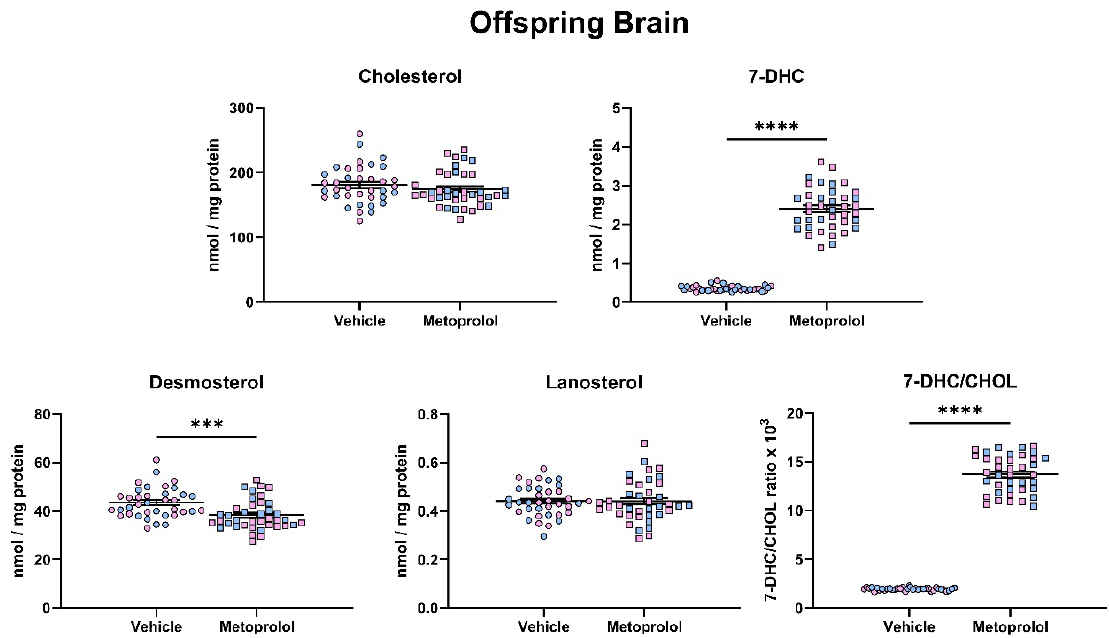
Figure 5. Maternal exposure to metoprolol results in strong elevation of 7-DHC and decreased desmosterol levels in the offspring brain. Pregnant mice were treated with 35 mg/kg MTP from E12 to E19. E19 brains were analyzed for sterol content by LC-MS/MS. Each symbol represents a sample originating from a single offspring brain. Blue fill = male embryos, pink fill = female embryos. Note the strong change in 7-DHC/CHOL (precursor/product) ratio. Statistical significance: *** p < 0.001; **** p < 0.0001.